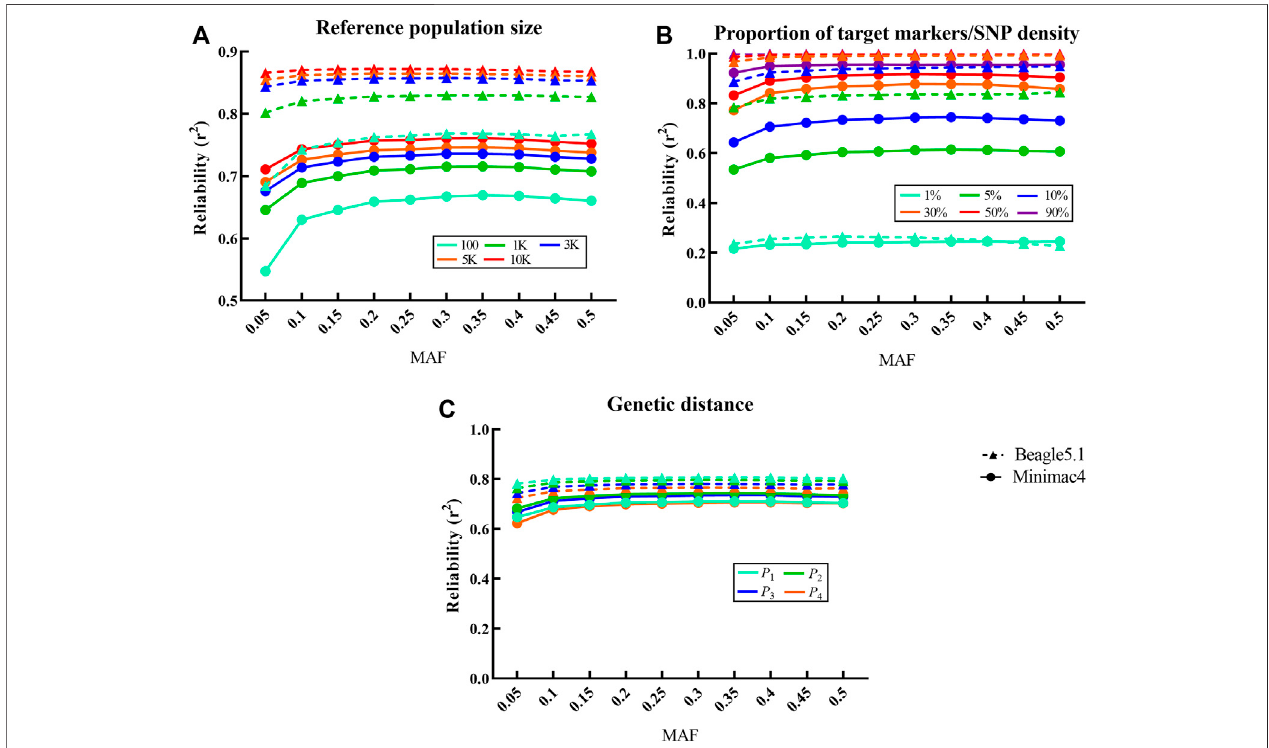
FIGURE 2 | In fl uence of different factors on imputation reliability in LCWGS data. For each fi xed level of the factors under each scenarios, the average at different levels of all other factors is taken as the reliability. Imputed alleles are binned according to their MAF count in each scenarios. Dotted line with a triangle sign represents Beagle5.1, while the solid line with a round sign represents Minimac4. Different colored signs represent different levels. (A) In fl uence of reference population size on imputation reliability. (B) In fl uence of the proportion of target markers or SNP density on imputation reliability. (C) In fl uence of genetic distance between reference population and target population on imputation